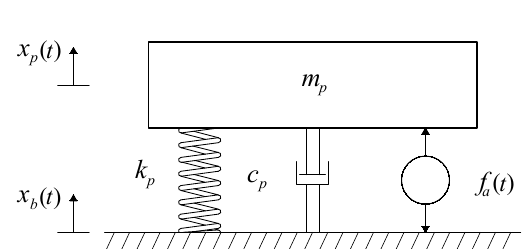
Figure 1. Single isolator on a rigid supporting